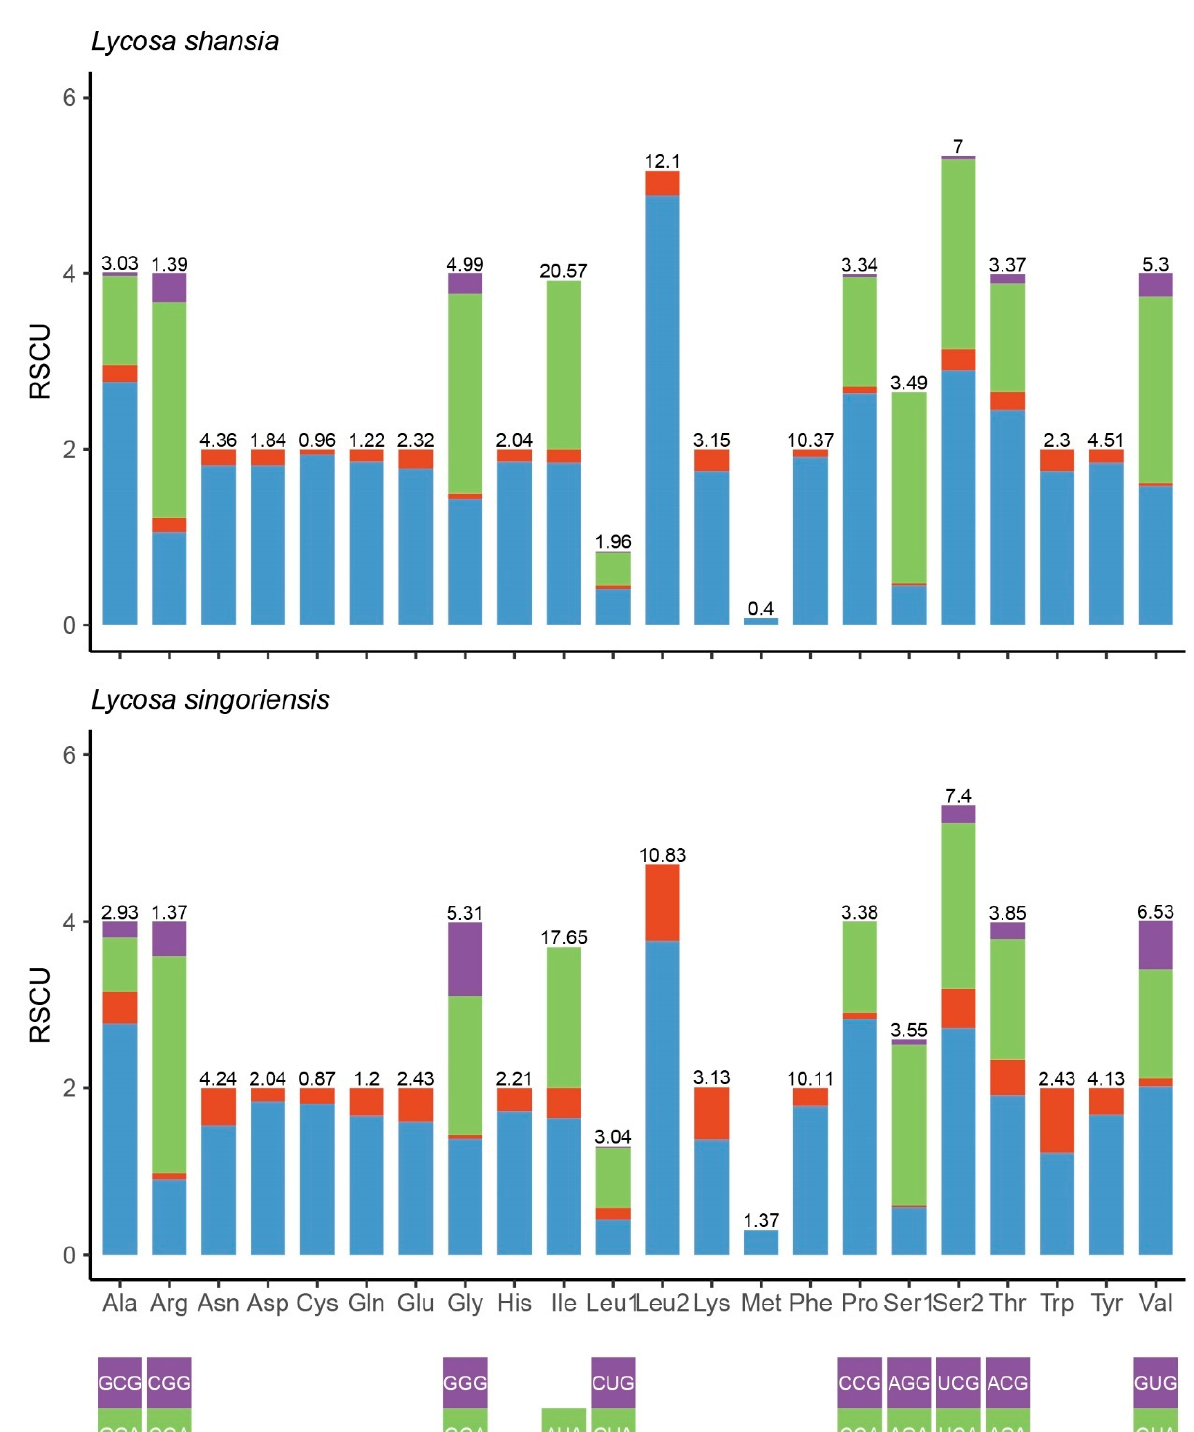
Figure 4. The codon distribution and RSCU of L. shansia and L. singoriensis . The lengths of the PCGs detected in the two newly sequenced mitogenomes ranged from 151 bp to 1632 bp (Table 3). The AT-skew of the L. shansia PCGs ranged from − 0.42 to 0.01, while that of L. singoriensis ranged from − 0.22 to 0.05. Most PCGs used the standard